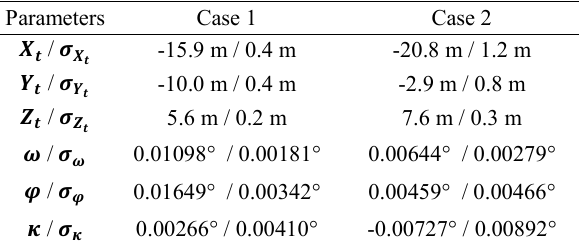
Table 1. Transformation parameters and the standard deviations of point-to-surface matching Figure 9 shows the 3D distances between 505 ICESat points and the surface points before and after matching for Cases 1 and